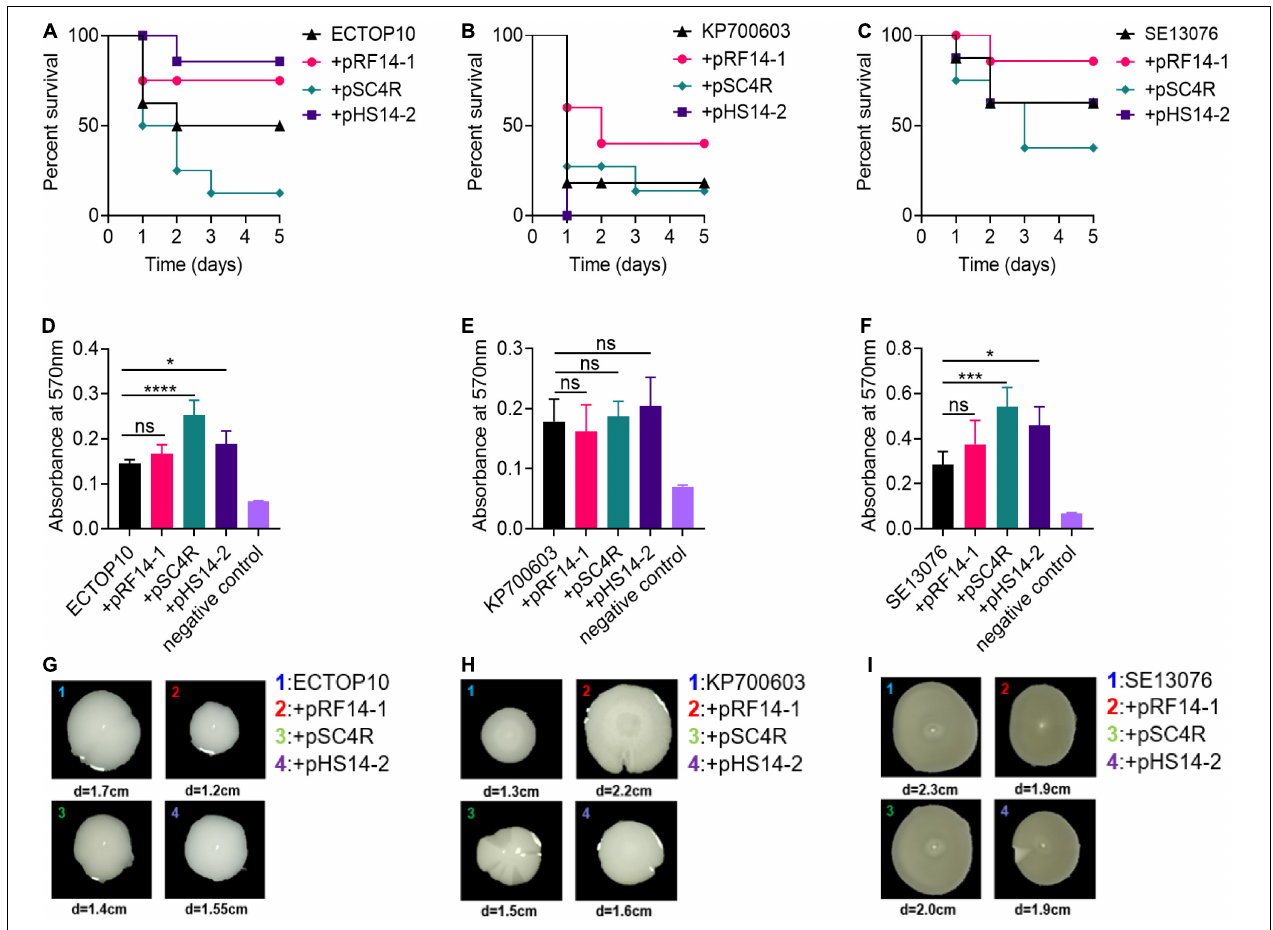
FIGURE 3 | Effect of tet (X4)-bearing IncX1 plasmids encoding H-NS on the virulence phenotype of different recipient strains. (A–C) Survival of G. mellonella larvae infected by recipient strains and corresponding transformants, including E. coli TOP10 (A) , K. pneumonia e ATCC700603 (B) , or S. Enteritidis ATCC13076 (C) . (D–F) Biofilm formation ability of three recipient strains and corresponding transformants, including E. coli TOP10 (D) , K. pneumoniae ATCC700603 (E) , or S. Enteritidis ATCC13076 (F) . Biofilm mass was monitored using crystal violet staining. Data are representative of three biological replicates and shown as mean ± SD. p -values were determined using a non-parametric one-way ANOVA (* p < 0.05; *** p < 0.001; **** p < 0.0001; ns, not significant). (G–I) Swimming motility of three recipient strains and corresponding transformants. The mean diameters from three biological replicates were